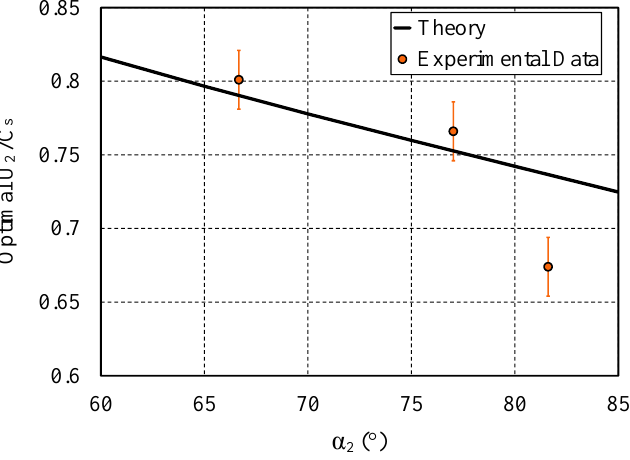
Figure 9. Comparison between the U 2 / C s theoretical approach and experimental data available for the PTM turbine. The theoretical curve is plotted for β 2